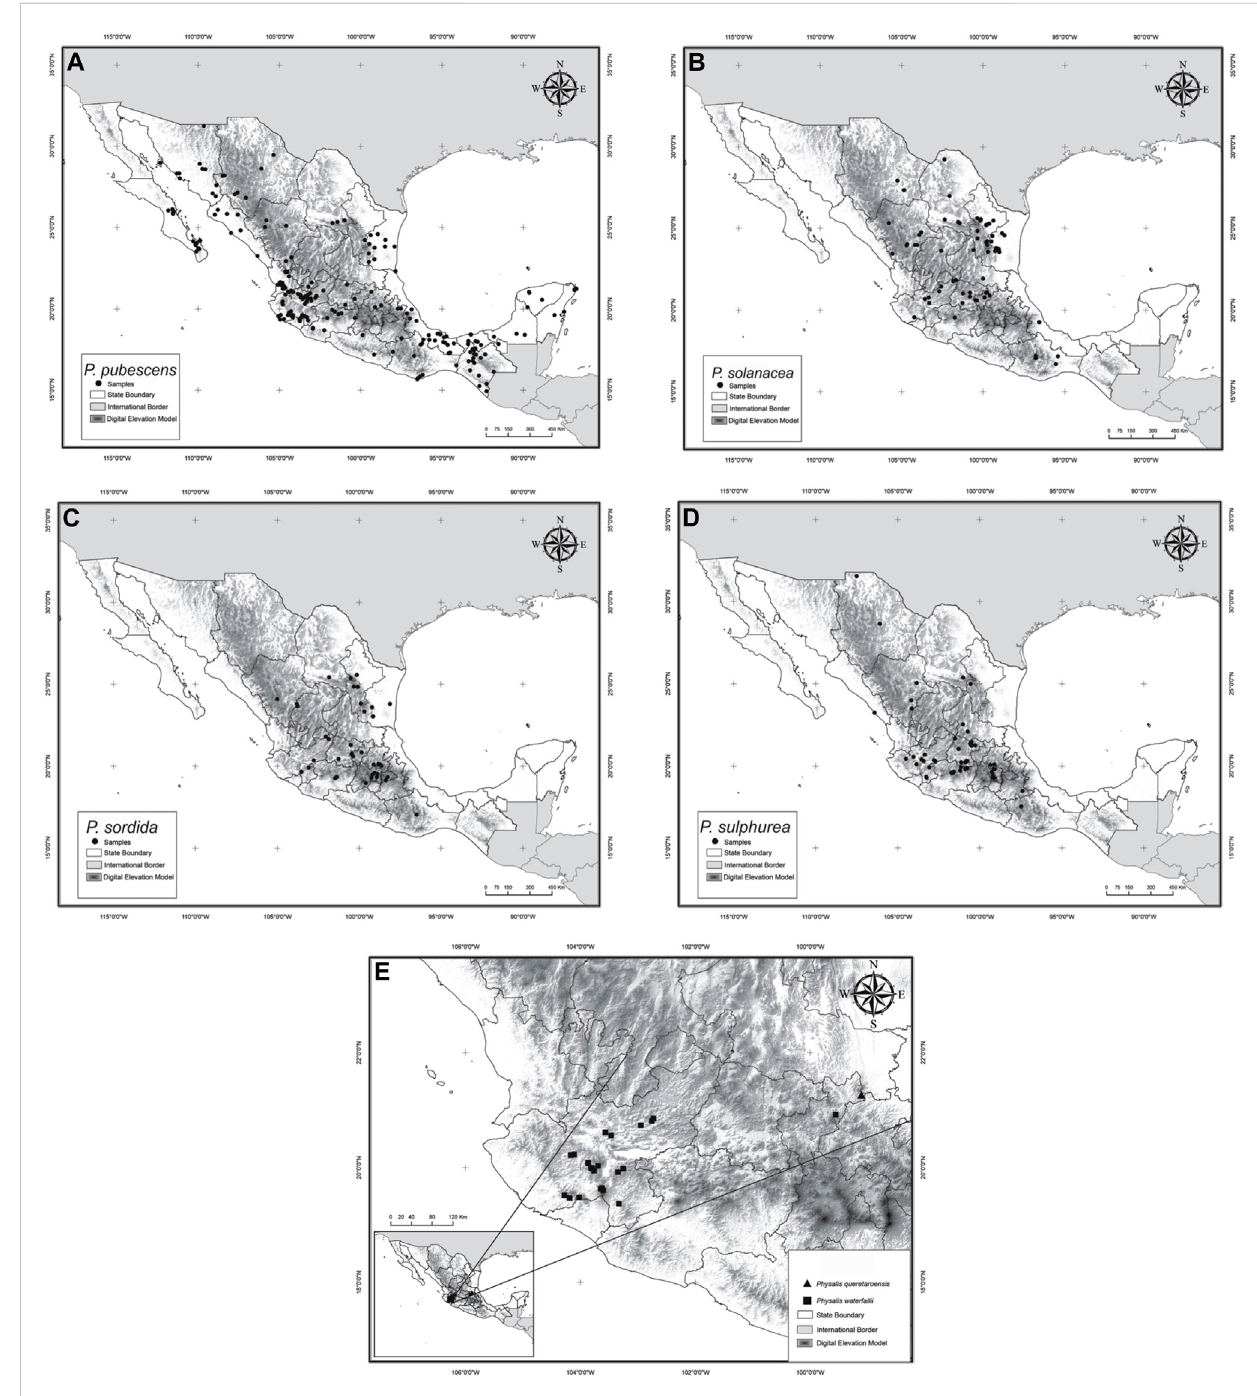
Geographic distribution of Physalis spp . (A) P. pubescens , (B) P. solanacea , (C) P. sordida , (D) P. sulphurea , (E) P. queretaroensis and P. waterfallii